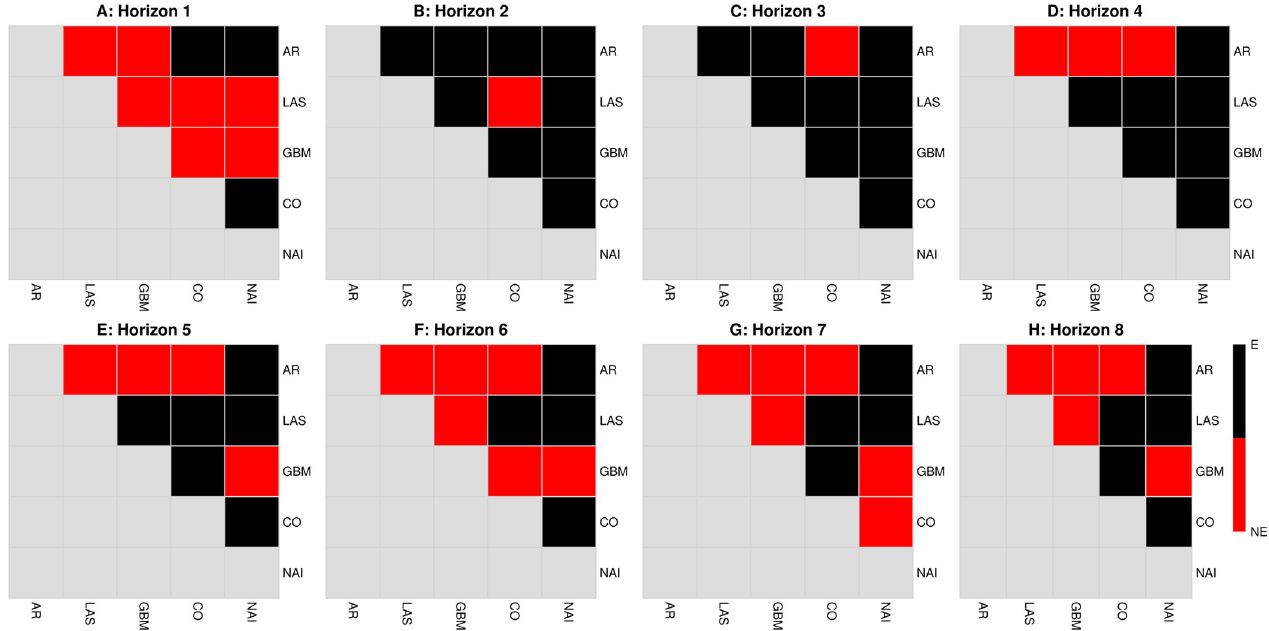
Fig 3. Visualization of Diebold-Mariano (DM) test statistic to test statistical equivalence of forecast errors across models and forecast horizons. Different panels represent the equivalence (E) in black or non-equivalence (NE) in red of forecasts for a specific horizon. This was computed for forecast residuals in the full forecasting dataset in the baseline autoregressive (AR) model, the Least Absolute Shrinkage and Selection Operator (LAS), gradient boosted machines (GBM), a simple average of all forecasts (CO) and the na ï ve forecast (NAI). Elastic net generated the same regularization as Least Absolute Shrinkage and Selection Operator across all horizons and the DM test statistic was not